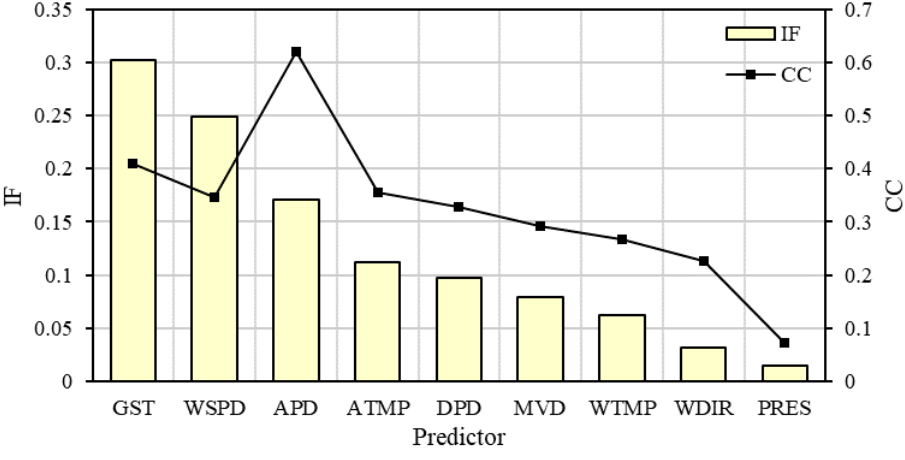
Table 2. Comparison of IF and CC. Statistically significant values at the 90% level are highlighted.